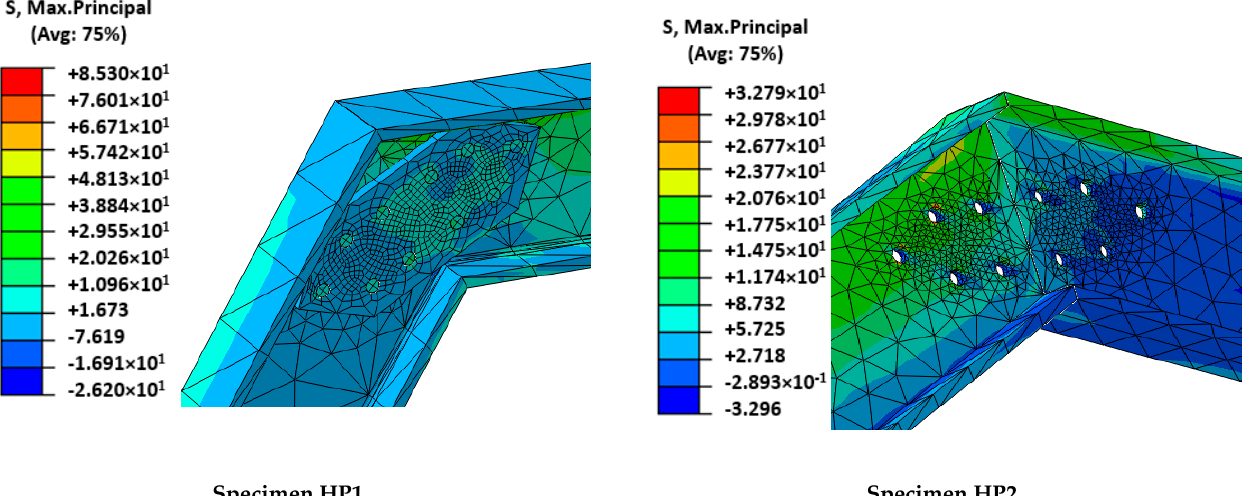
Figure 9. Stress distribution around connection area between FRP and FRP.